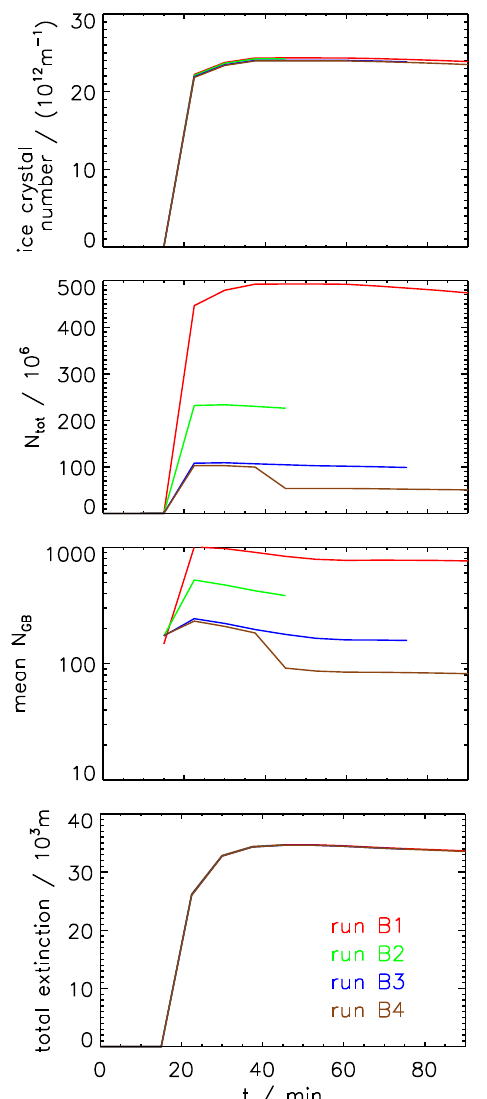
Fig. 7. Temporal evolution of total extinction E , total ice crystal Fig. 37. Temporal evolution of total extinction E , total ice crys- tal number N , total SIP number and mean SIP number per grid number N , total SIP number and mean SIP number per grid box box for setups with different SIPMERGE parameters (see legend). for setups with different SIPMERGE parameters (see legend). Pa- Parameter settings of the simulation series are listed in Table 34. rameter settings of the simulation series are listed in Table 4. The The fast updraught case with w syn = 20cm / s , n min = 10m − 3 and fast updraught case with w syn = 20cms − 1 , n min = 10m − 3 and ∆ t NUC = 0 . 2s is depicted (cf. with red dotted line in left panel of 1t NUC = 0.2s is depicted (cf. with red dotted line in left panel of Figure 36). Fig.